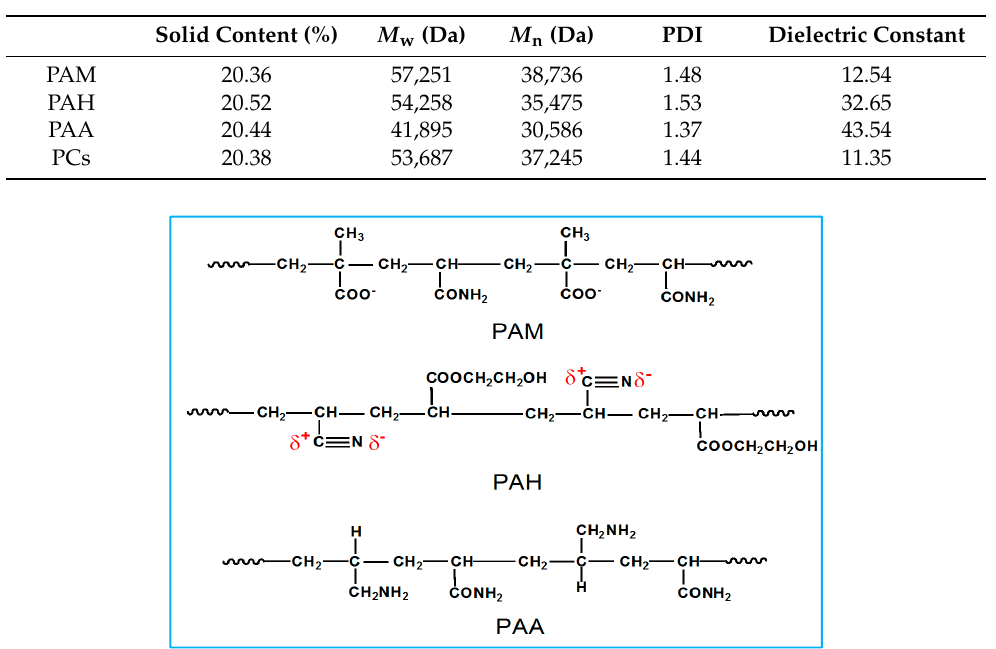
Table 1. M w , M n , and polydispersity (PDI) of polymer dispersants and their dielectric constant.